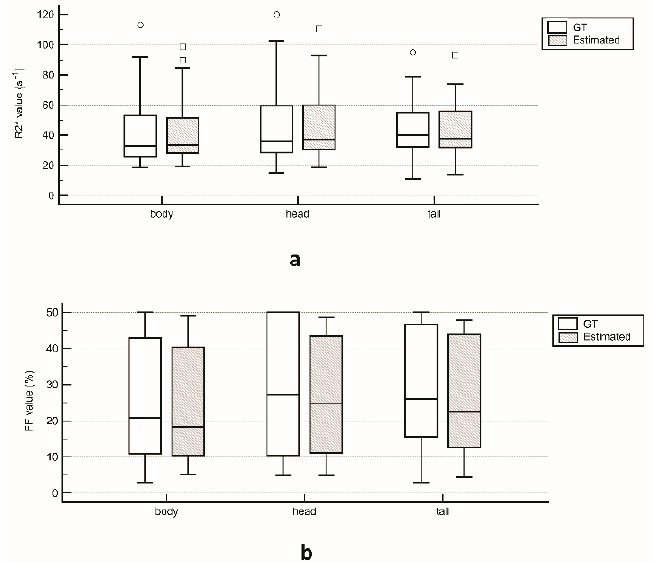
Figure 4. Ground Truth (GT) and estimated R2* ( a ) and FF ( b ) values among the three pancreatic regions.